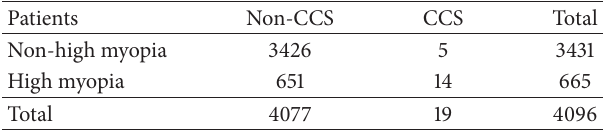
Table 1: Number of CCS cases among cataract patients with or withouthighmyopiaattheEyeandENTHospital,FudanUniversity, Shanghai, China, between September 1, 2012, and March 31, 2013.